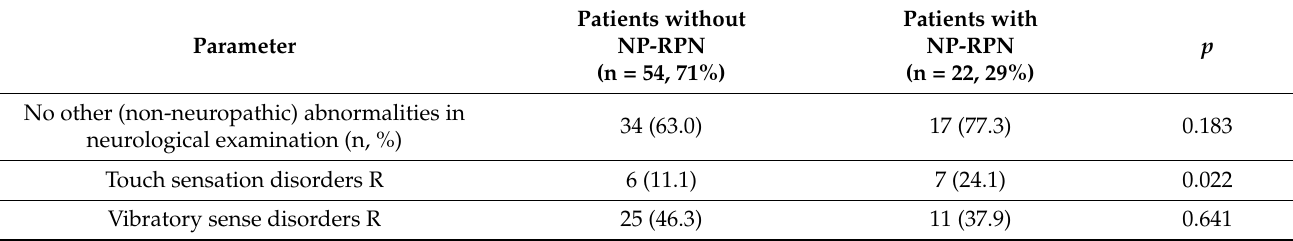
Table 3. Alterations in neurological examination in patients without and with